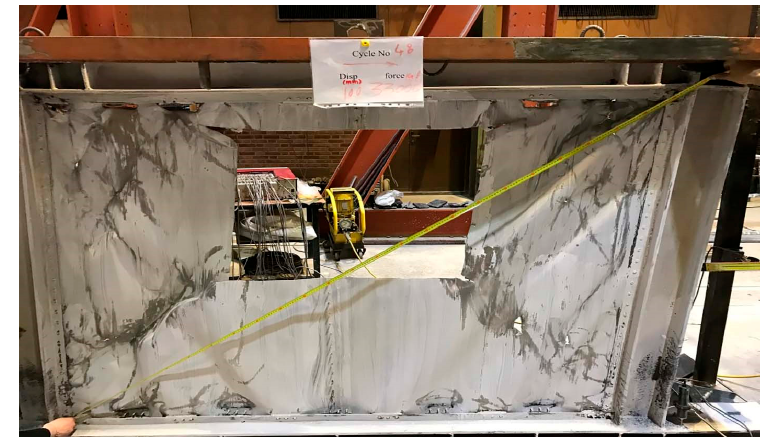
Figure 10. Specimen 1 at the end of